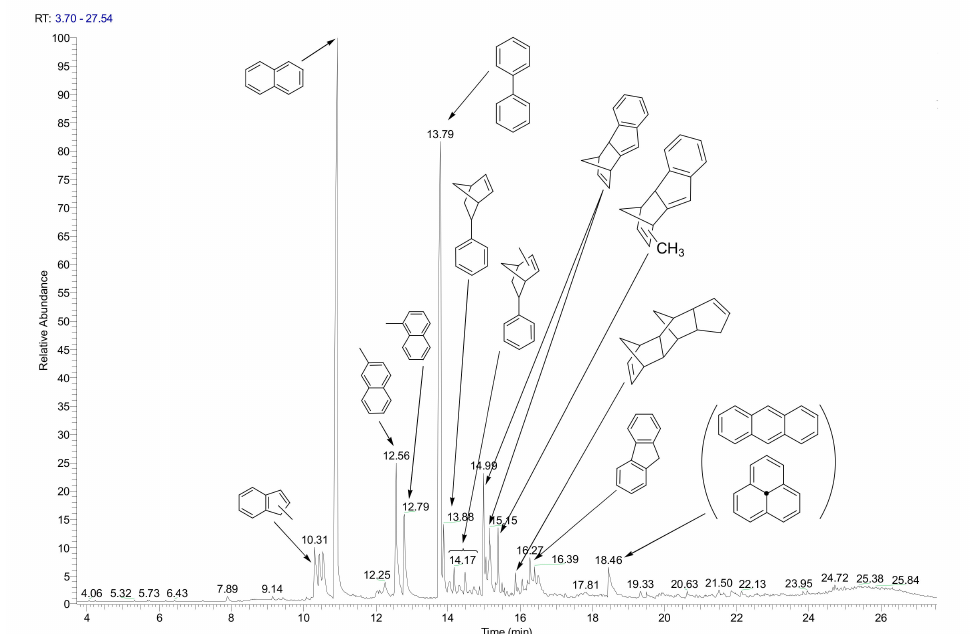
Figure 8. GC-MS plot of pyrolysis fuel oil